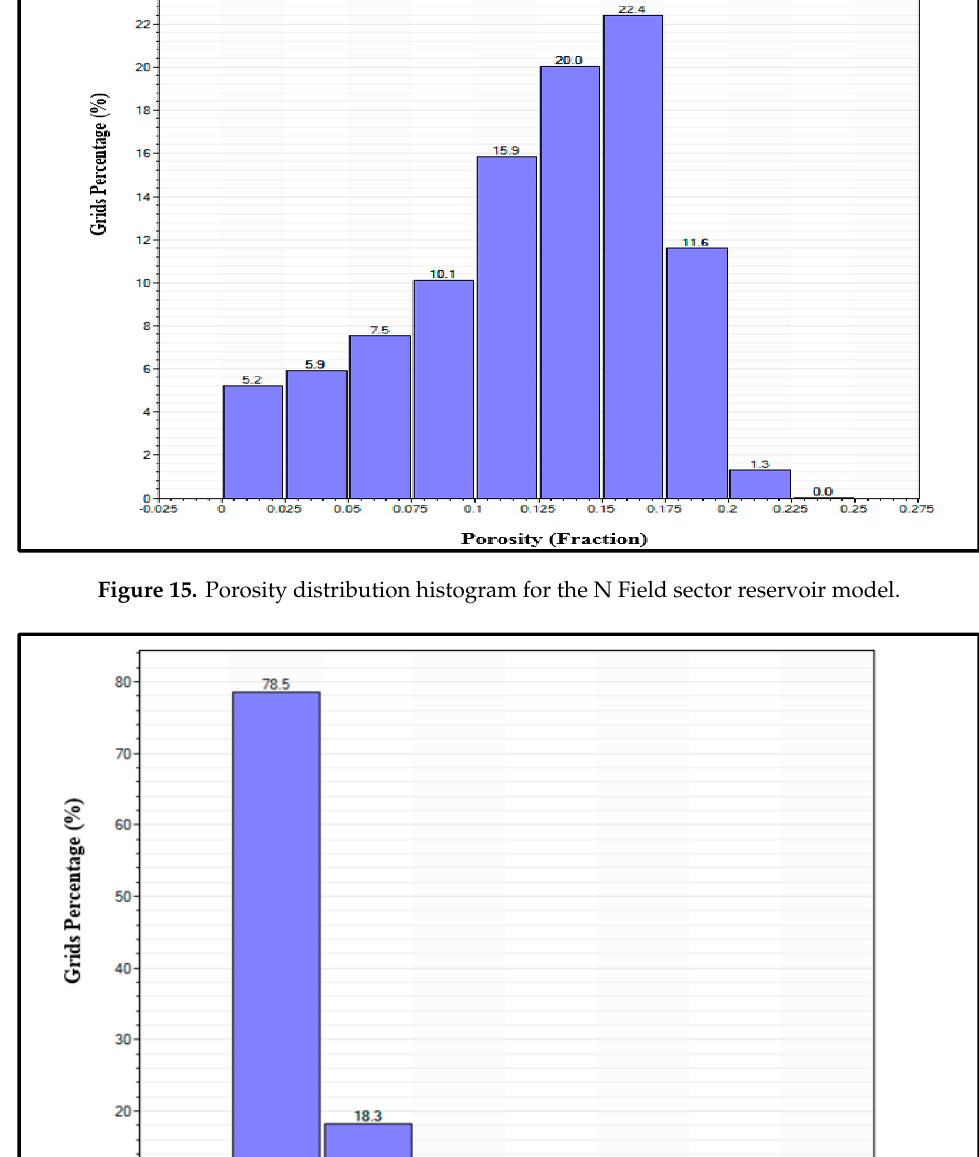
Figure 14. 3D reservoir grid system for the N Field sector model and well locations.